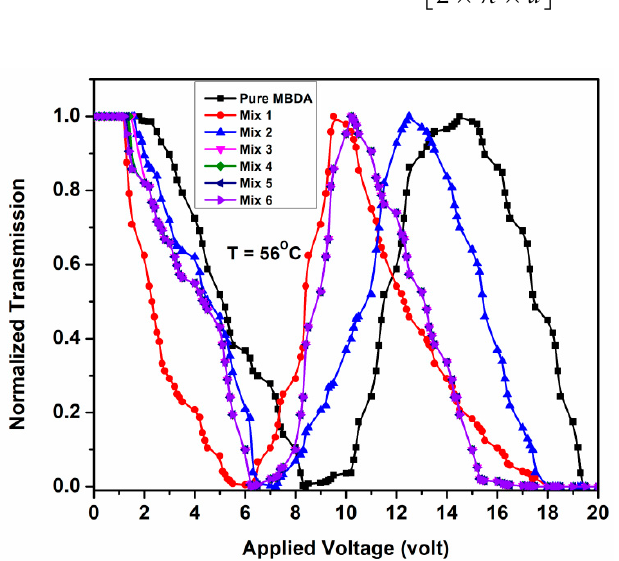
Figure 10. Variation of transmission with voltage (V–T plot) for the pure nematic MBDA and its mixture with core/shell quantum dots (Mix 1 to Mix 6).